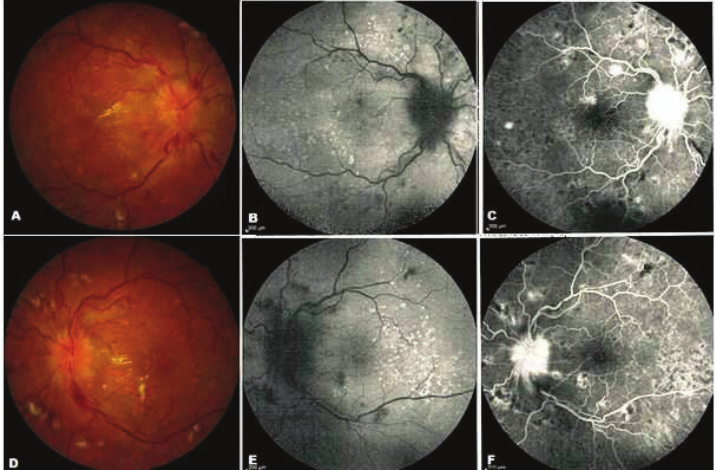
Figure 1. (A & D) Fundus photographs of the right and left eyes show the arterial narrowing, vascular tortuosity, flame- shape hemorrhage, hard exudates, optic disc swelling, and Elschnig spots. (B & E) The fundus autofluorescence illustrates hypoautofluorescence around the optic disc and multiple hyperfluorescence spots compatible with Elschnig spots. (C & F) Fluorescein angiography of both eyes in late phases shows the optic nerve leakage and hypofluorescence spots with hyperfluorescence borders that coincide with Elschnig spots.